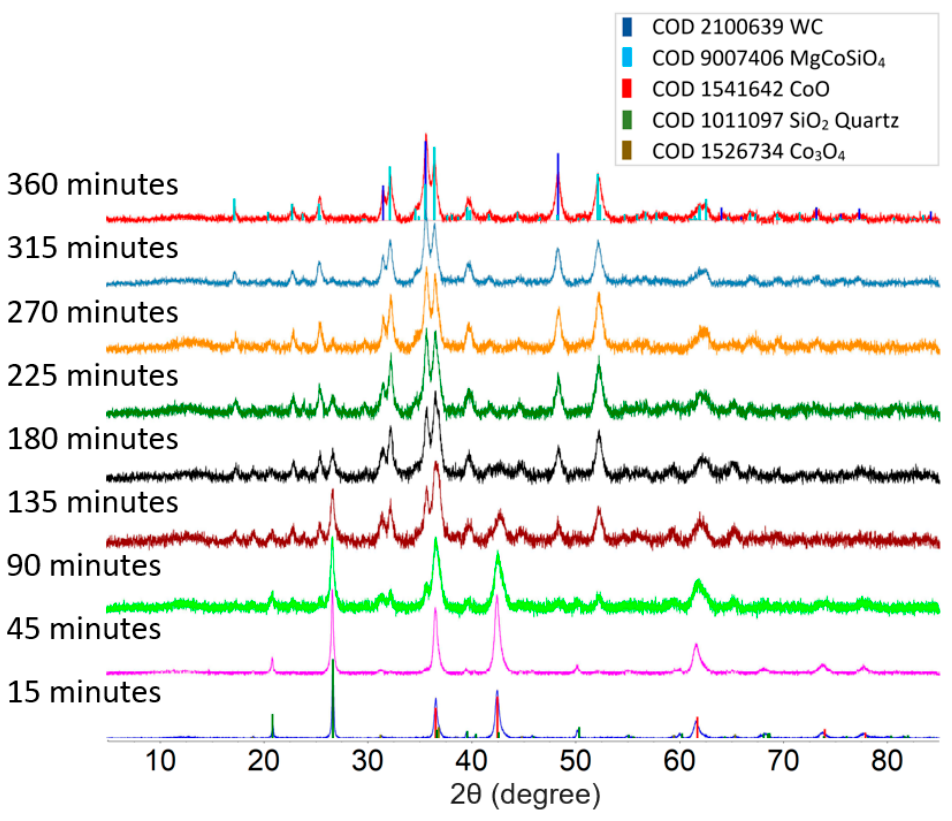
Figure 2. Powder XRD pattern of 1:1:1 molar ratio of MgO, CoO, and SiO 2 mixture after various milling times. MgO turns amorphous after milling for 15 min.